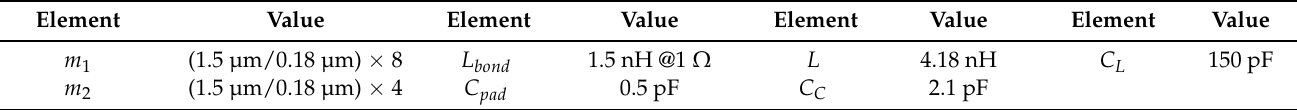
Table 7. Elements and transistor sizes of the power harvester